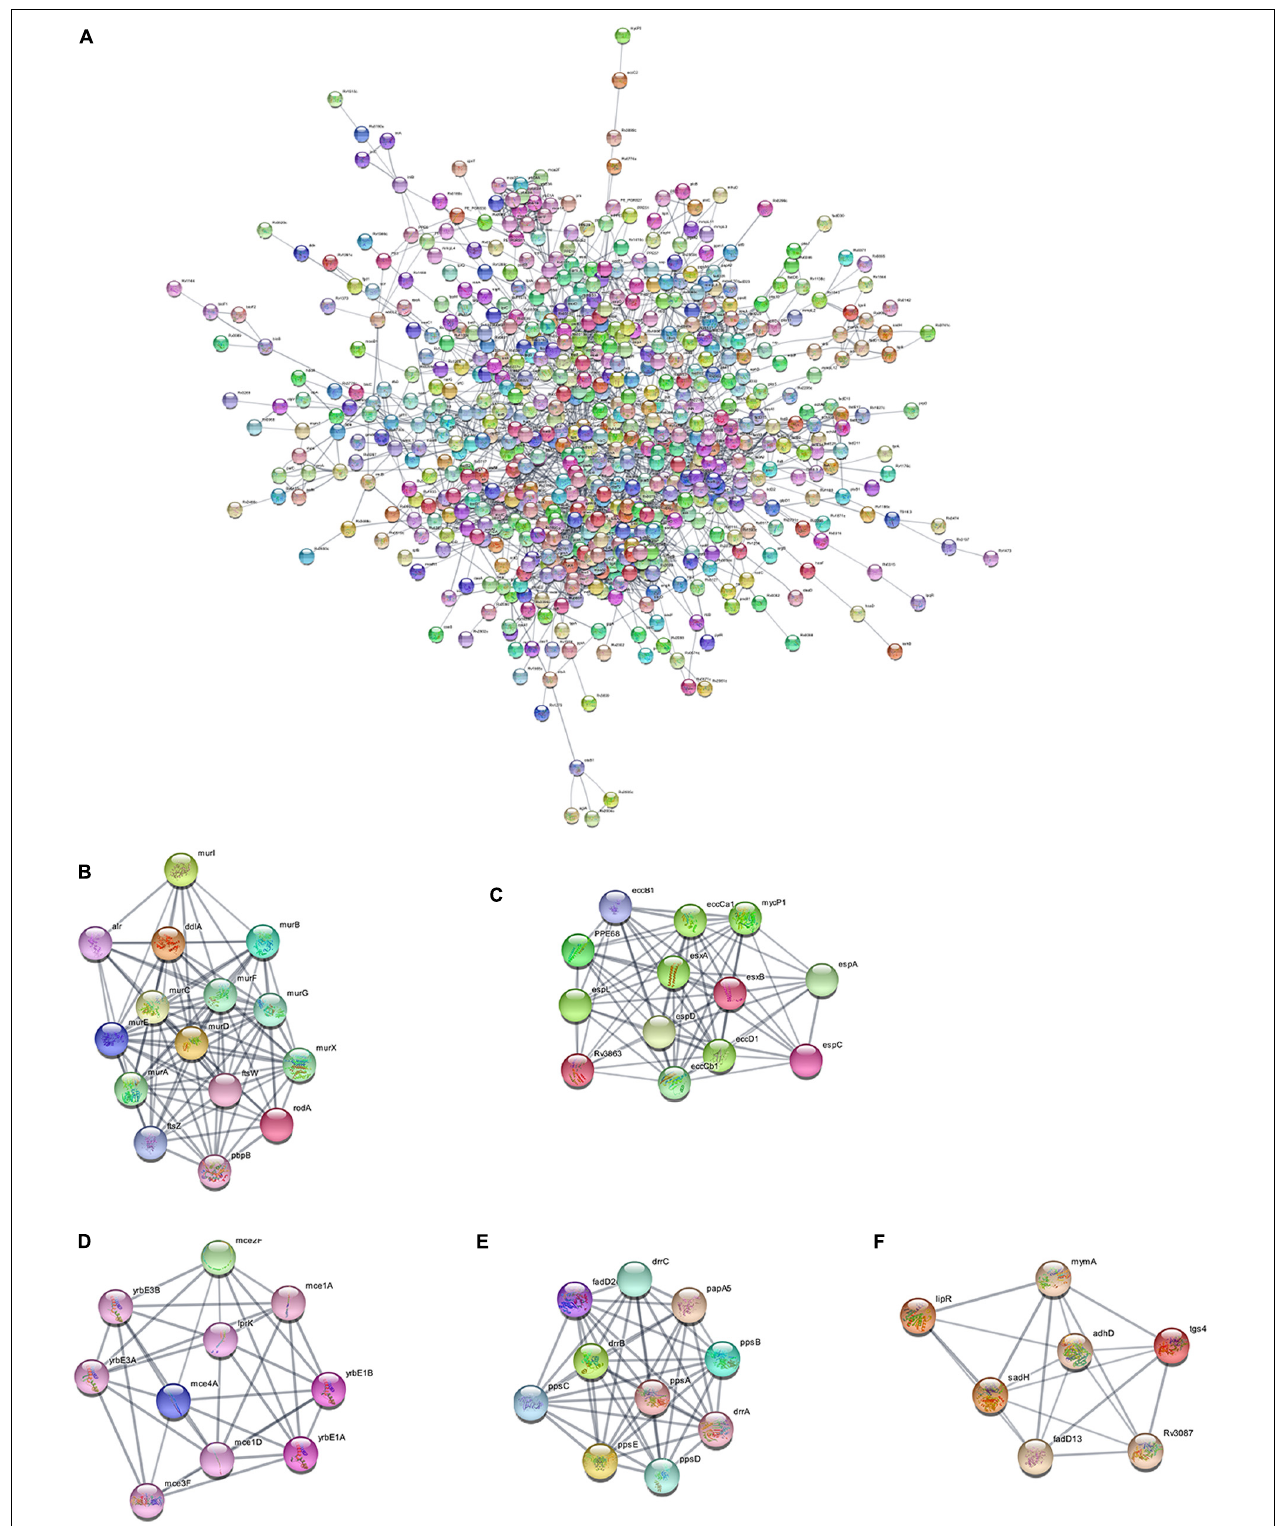
FIGURE 6 | PPI network of cell wall-related genes of M. tuberculosis . (A) Protein interaction networks visualized with Cytoscape. (B) Molecular complex detection (MCODE) with deep excavation of the core subnet. A modular gene involved in peptidoglycan synthesis in Subnet 1. (C) The gene cluster for the ESX-1 secretory system. (D) Gene clusters encoding membrane lipid transporters. (E) Key gene clusters for cell wall resistance. (F) Fatty acids modify gene clusters.